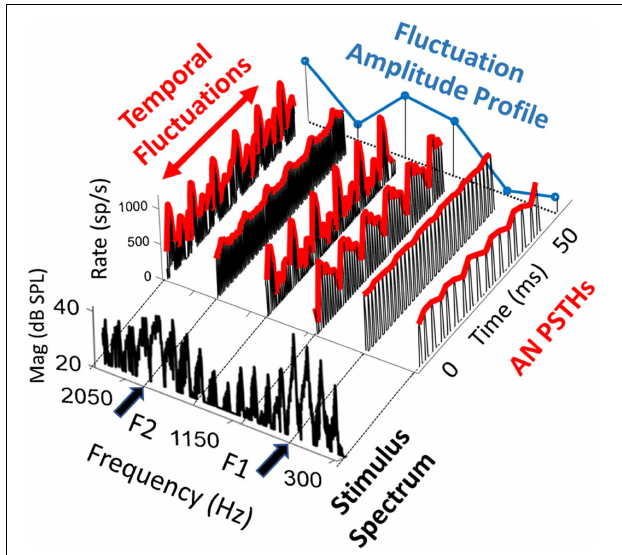
FIGURE 1 | Fluctuation profile of ANF response to vowel /ae/ spectrum, which is in the foreground. The model peristimulus time histograms (PSTHs) of HSR ANFs are presented at formant peaks (F1 = 700 and F2 = 1800 Hz) and troughs. Temporal fluctuation is large at trough frequencies and small nor none at the formants, forming the dips in the fluctuation amplitude that mirrors the formants. Adapted from Carney